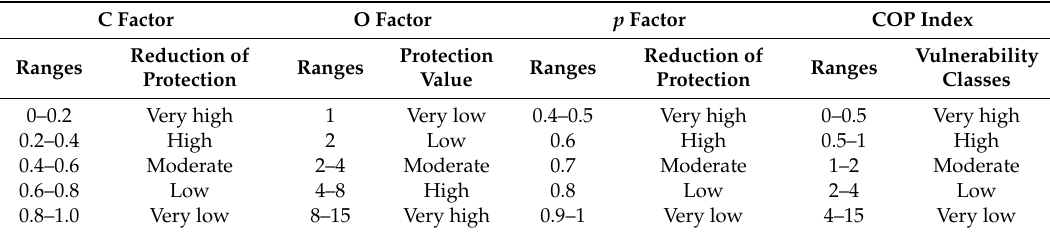
Table A3. Values for COP parameters and vulnerability classes for the COP index.